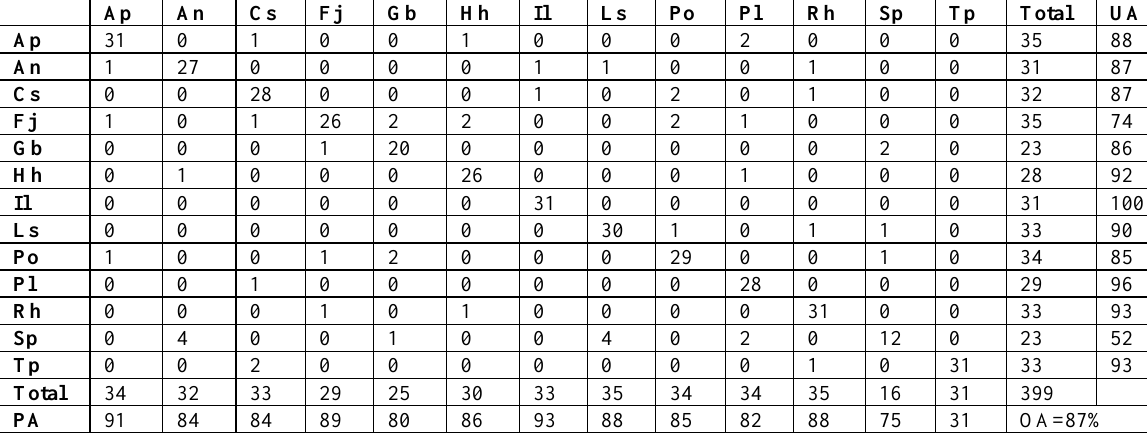
Table 2: Confusion Matrix of Support Vector Machine Used Redial Base Function Classifier (SVM-RBF Kernel)